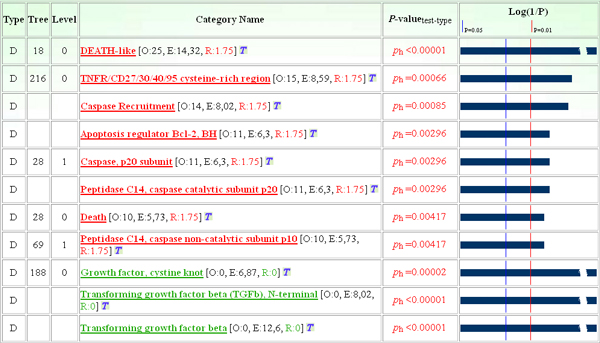
GFINDer Statistics Protein Familes&Domains module: protein domain analysis. InterPro protein domains most significantly over- (red) and under-represented (green) in the considered apoptosis versus growth factor related gene classes; Type: type of InterPro entry (D: protein domain); Tree: tree label in the defined protein domain parent/child hierarchy, if any; Level: level in the related tree of the defined protein domain parent/child hierarchy, if any (higher levels correspond to more specific protein domains); P-valuetest-type: p value defining relevance of a given protein domain (Category Name) for a considered class of genes, and initial of used statistical test name (h: hypergeometric distribution test).